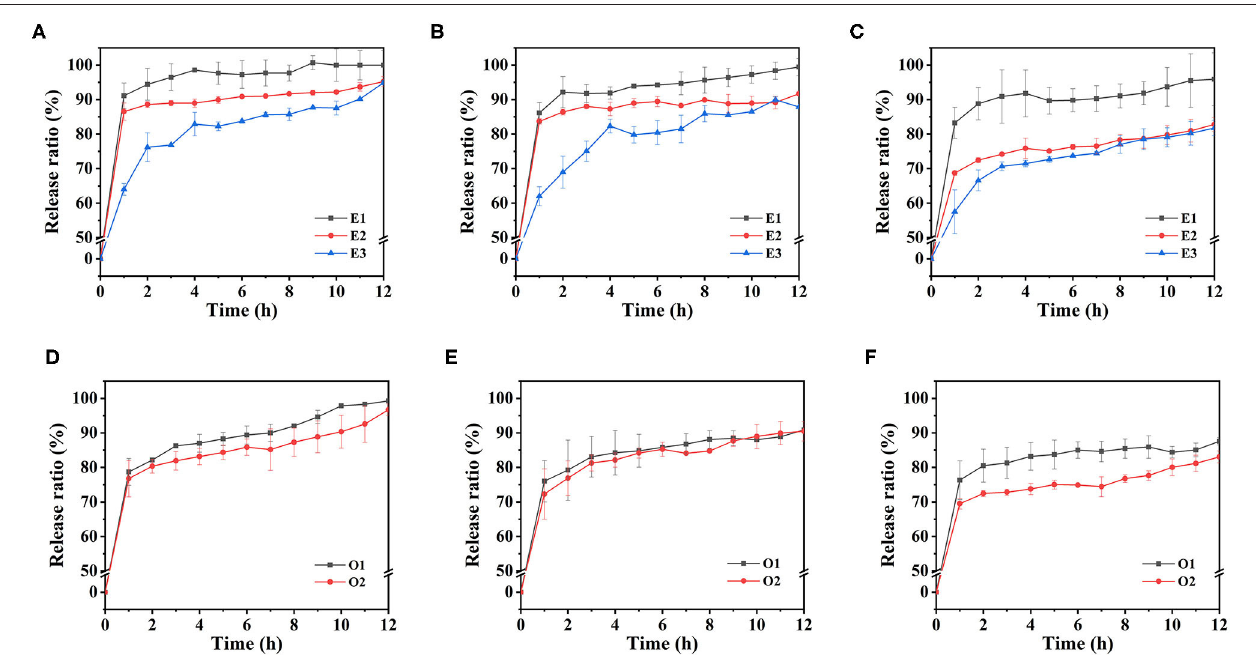
FIGURE 10 | The calcium release curves of emulsions in simulated gastric fluid environment: E1, E2, and E3 emulsions with 1% SA (A) , 1.25% SA (B) and 1.5% SA (C) , O1 and O2 emulsions with 1% SA (D) , 1.25% SA (E) and 1.5% SA (F) .